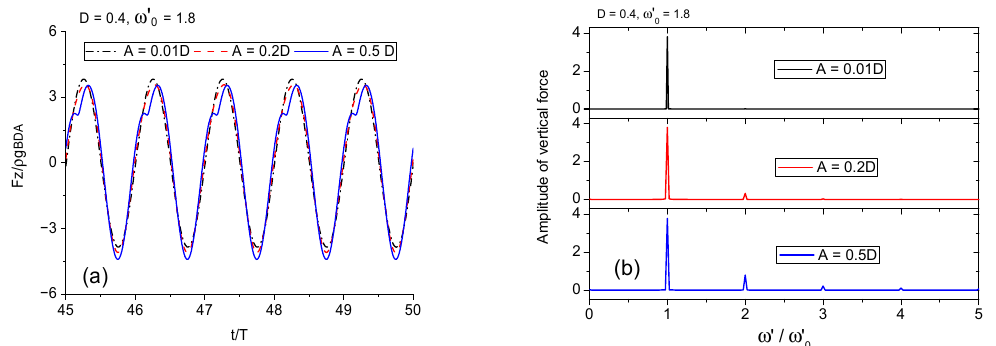
Figure 7. Hydrodynamic force histories and their corresponding amplitude spectral analyses of D = 0.4, ω (cid:48) = 1.8: ( a ) vertical force histories; ( b ) Fast Fourier Transform (FFT) analysis of the vertical forces.